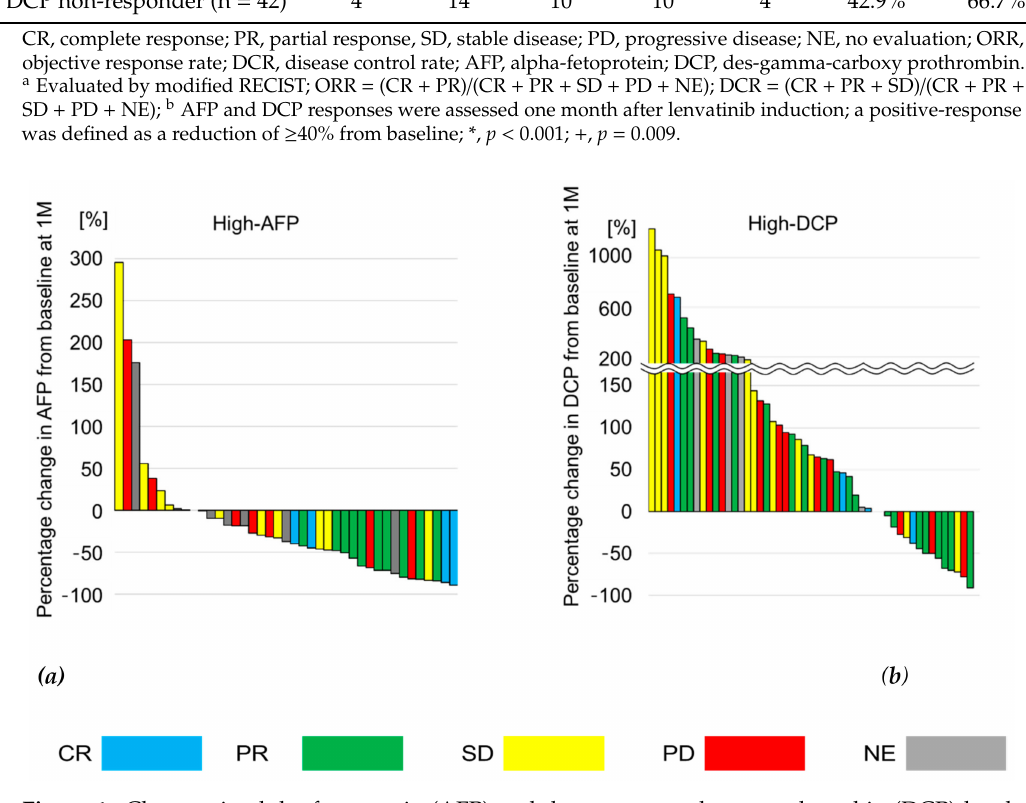
Figure 1. Changes in alpha-fetoprotein (AFP) and des-gamma-carboxy prothrombin (DCP) levels from baseline in the high-AFP group and the high-DCP group. ( a ) The median rate of change in AFP was − 69.0% ( − 47.1% to − 82.6%) in imaging responders (blue and green), while it was − 17.7% ( − 37.2% to + 0.5%) in imaging non-responders (yellow, red, and gray). ( b ) The median rate of change in DCP was + 30.6% ( − 42.8% to + 118.9%) in imaging responders and + 107.6% ( − 4.7% to + 262.3%) in imaging